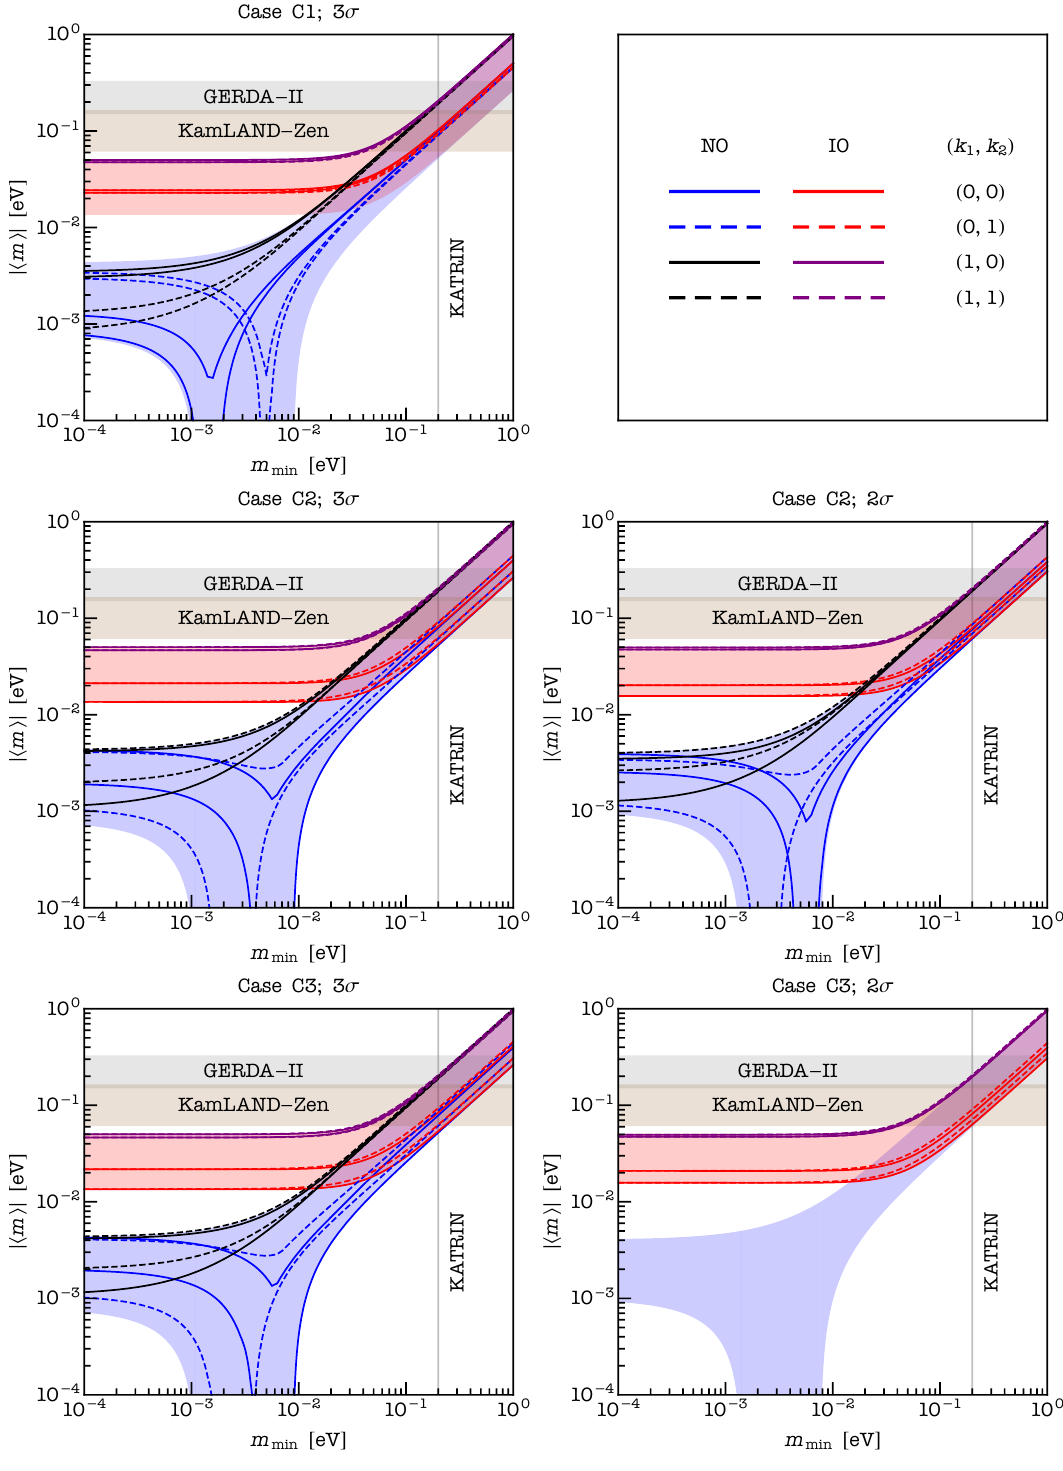
Figure 14 . The same as in (cid:12)gure 13, but for cases C1{C3. Case C1 is compatible with the 3 (cid:27) ranges of the mixing angles, but not with their 2 (cid:27)